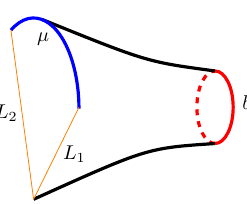
Figure 3 . One important ingredient in the calculation of the leading order correction to the inner product h L 1 | L 2 i via Euclidean path integral. We see the two geodesics L 1 and L 2 in orange, the EOW brane in blue and a closed geodesic b in red. The wavefunction of this geometry is denoted by Ψ T ( b, L 1 , L 2 ) . Topologies beyond the disk are important in recovering ETH-like